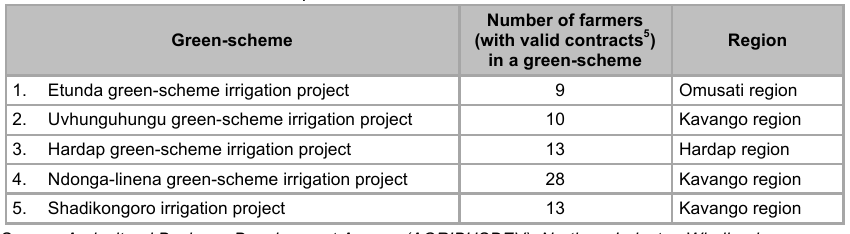
Number of farmers (with valid contracts 5 ) Region in a green-scheme 9 Omusati region